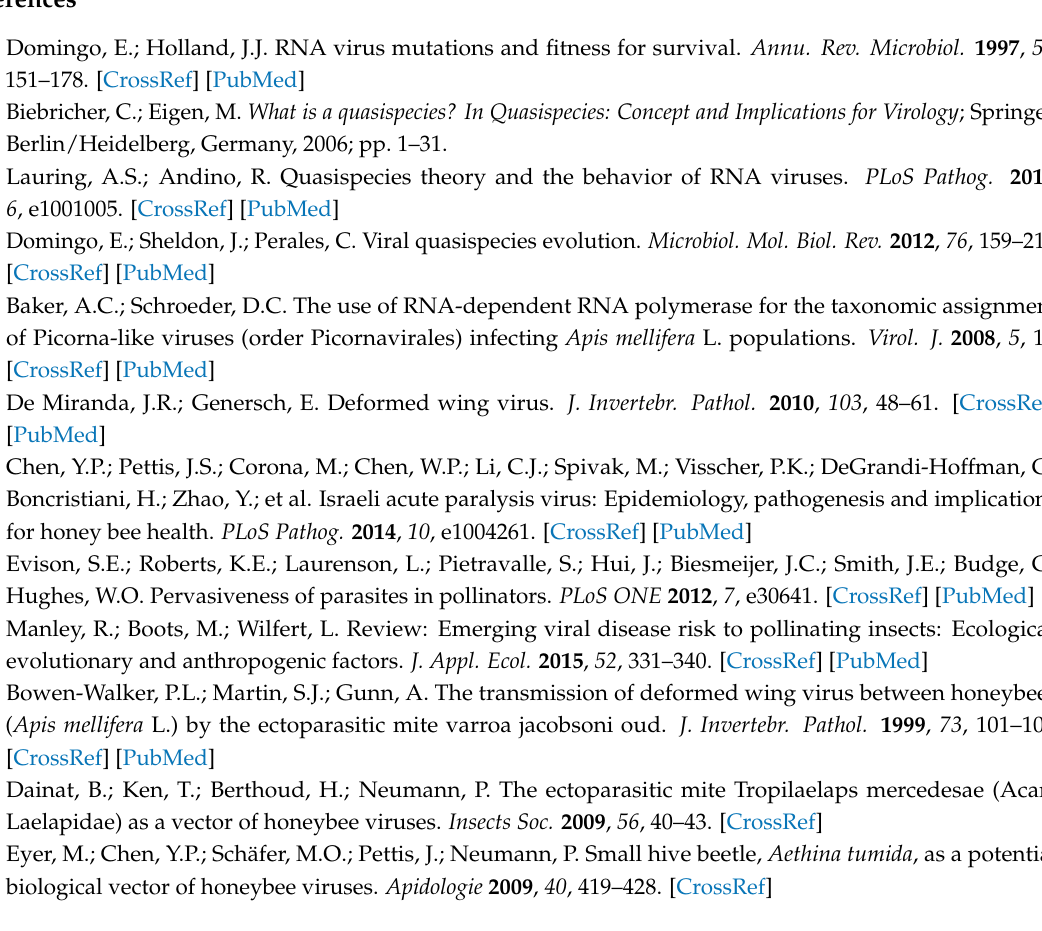
Figure S1: validation of specificity of target amplification through (A) Melt curve analysis and (B) sequencing of resultant PCR product, Figure S2: HRM melt curves of monthly samples from colonies that (A) GD1 = collapsed during the over-wintering period, i.e., over-wintering colony loss (OCL) and (B) GD2 = survived the following year, i.e., healthy colony. Shaded area indicates the melt position of the type B or C variants in the months may to Sep in the OCL